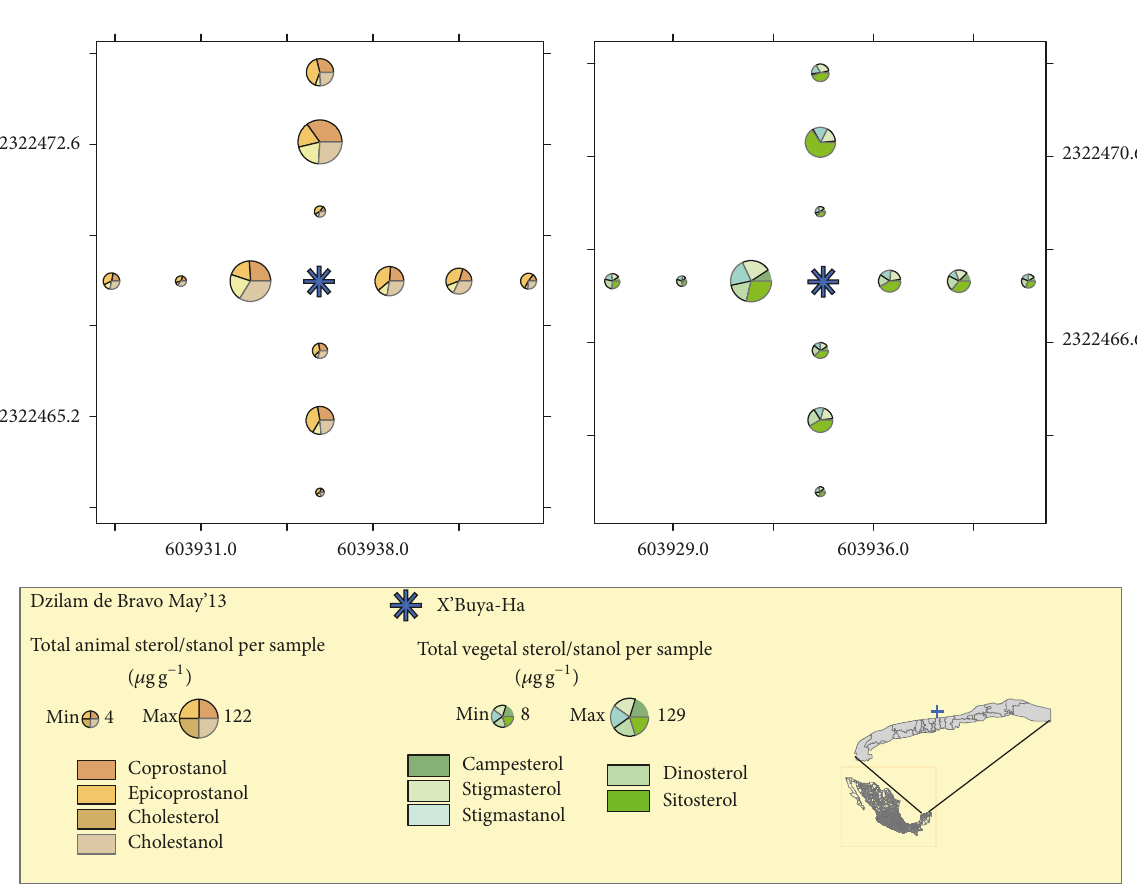
Projection of the variables on the factor-plane Dry season